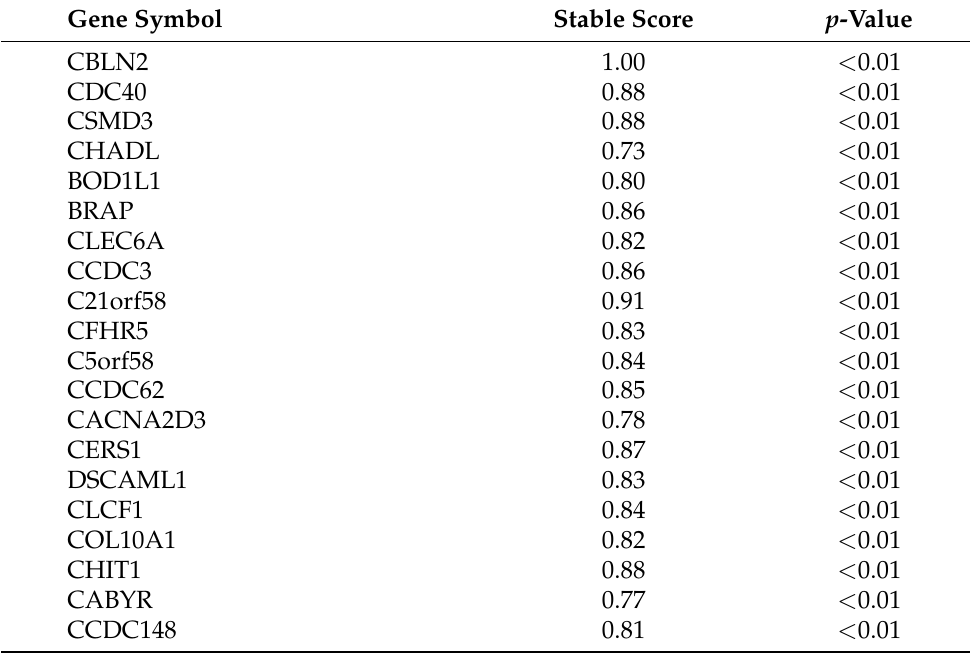
Table 5. The top-20 genes found in the COAD (colorectal cancer) dataset. Gene Symbol